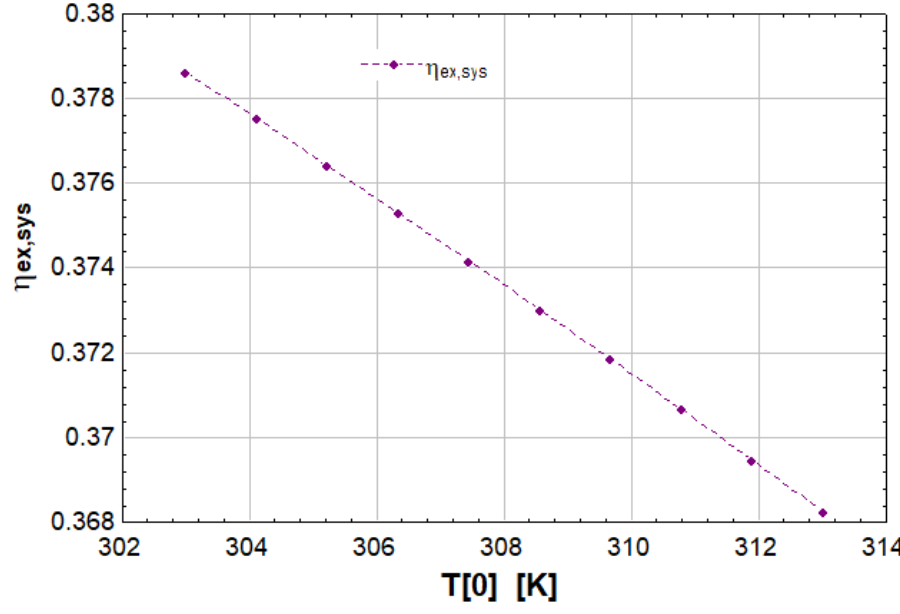
Figure 6. Effect of Ambient Temperature on Exergy Efficiency of Multigeneration System .